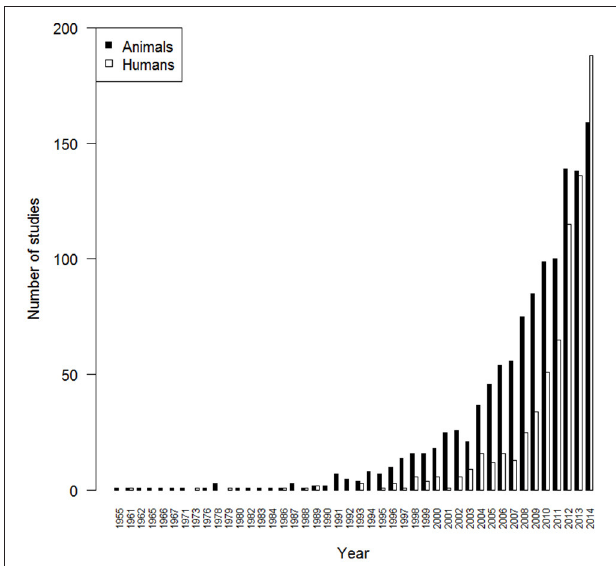
FIGURE 3 | Number of ARGOS satellite transmitters deployed. Time series of the number of ARGOS satellite transmitters deployed from 2004 to 2014 (data provided by CLS